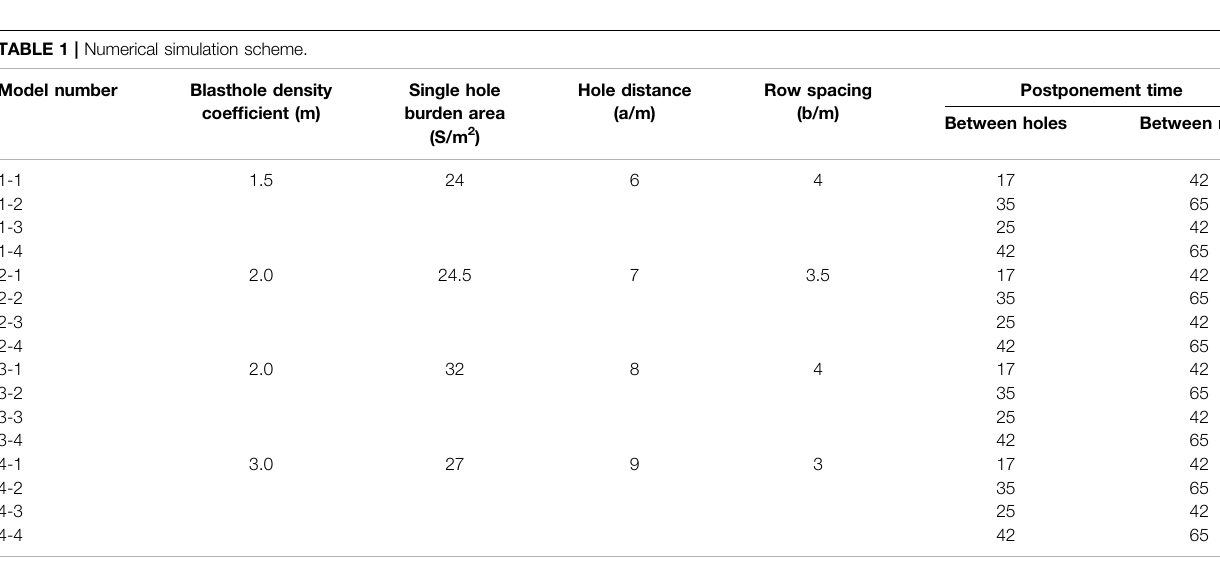
TABLE 1 | Numerical simulation